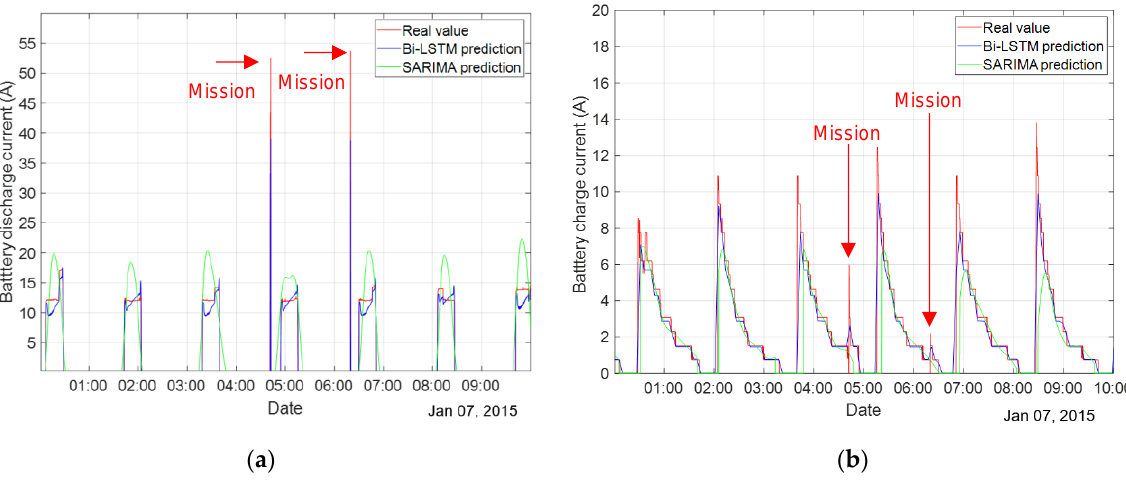
Figure 11. KOMPSAT-3A enlarged battery current prediction results: ( a ) discharge current; ( b ) charge current.